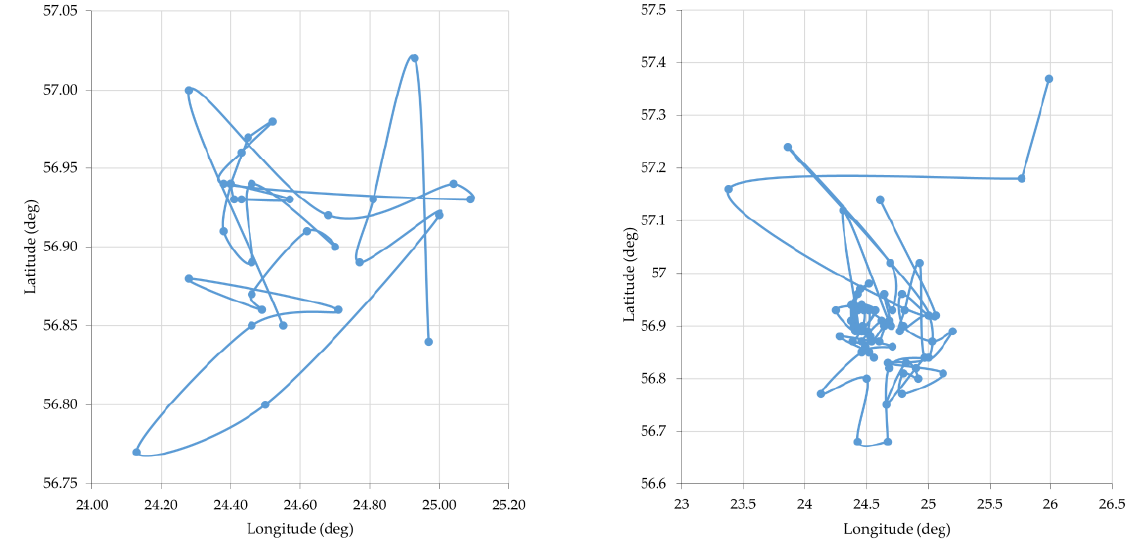
Figure 13. Center coordinate variations for 36 peak clouds in March 2015 (on the left side 𝑃 , see